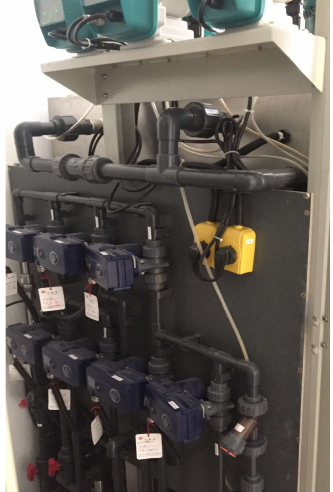
Figure 3. Pipeline distribution control